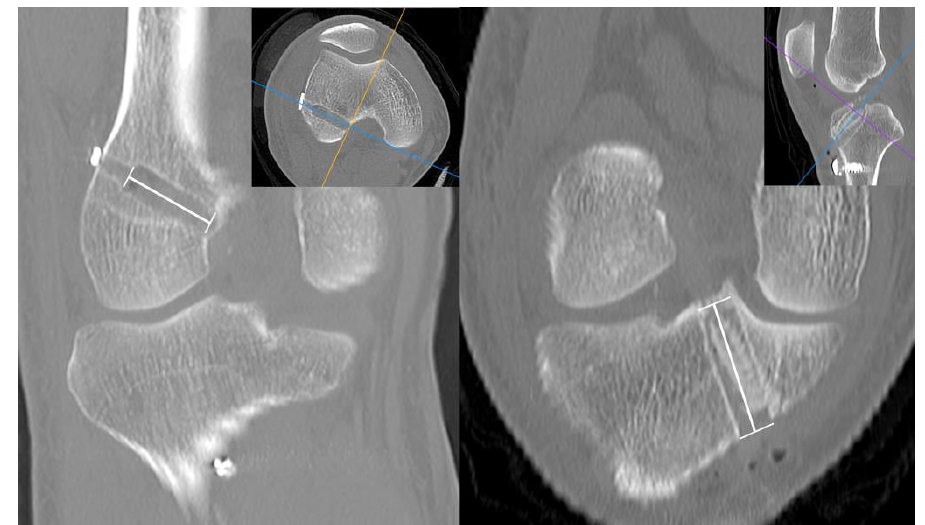
Figure 6. Measurement of the length of femoral and tibial tunnel on CT scan. All radiographic parameters were measured twice by two orthopedic surgeons with at least 4-week intervals between each measurement using a picture archiving and com- munication system (Centricity PACS Viewer; GE Healthcare, Chicago, IL, USA). Intraclass correlation coefficients (ICC) were used to determine intraobserver and interobserver re- liabilities. 2.4. Statistical Analysis The Shapiro – Wilk test was used to evaluate the normality of the distribution. Paired t -tests for continuous variables and chi-square tests for categorical variables were used to compare the preoperative and postoperative outcomes. To compare the demographic data as well as preoperative, intraoperative, and postoperative outcomes between the two groups, Student’s t -test or the chi-square test was used. Stepwise multiple regression anal- ysis was performed to identify which of the following factors were correlated with changes in the femoral and tibial TW on AP and lateral radiographs from the initial to 2- year follow-up. The independent factors were patient age, sex, body mass index, concom- itant meniscal injury, HKA angle, tibial slope, femoral and tibial tunnel positions, and the length of both tunnels. All data were analyzed using IBM SPSS Statistics (version 27.0; IBM, Armonk, NY, USA), and statistical significance was set at p < 0.05. Our study allo- cated 37 and 38 patients to the femoral TW ≥ 3 mm and <3 mm groups, respectively. It would take 89% statistical power to detect a difference of at least 1 mm with a standard deviation of 1.5 mm in STSD between the femoral TW ≥ 3 mm and <3 mm groups (α = 0.05). 3. Results All inter- and intraobserver ICCs showed good agreement with respect to the relia- bility of the radiographic measurements (>0.80). Mean differences in femoral and tibial tunnel widths on AP and lateral radiographs between the immediate and 2-year postoperative periods were 3.0, 2.5, 2.9, and 2.9, re- spectively, in the following order: femoral tunnel on AP, femoral tunnel on the lateral, tibial tunnel on AP, and tibial tunnel on lateral. Detailed tunnel widths are summarized in Table 3.